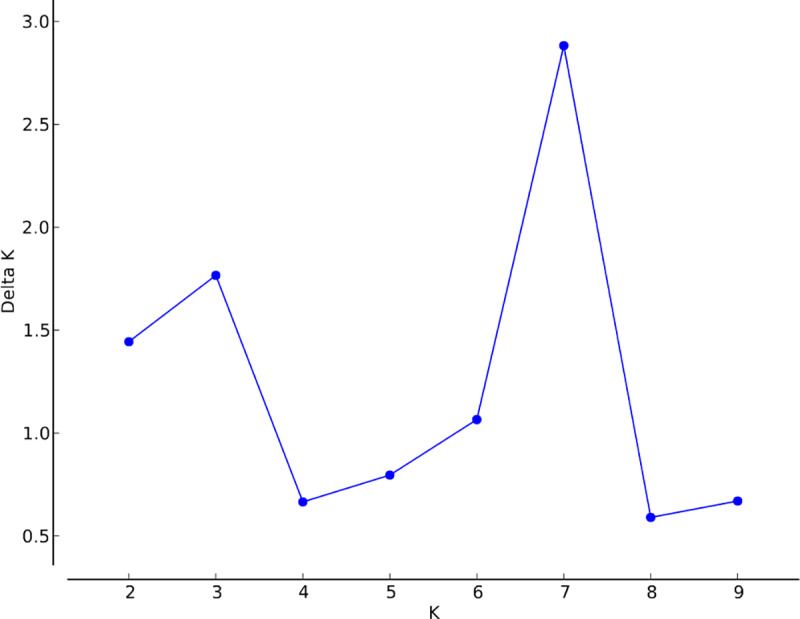
Structure Harvester Δ(K) plot, showing peaks for K of 3 and 7.